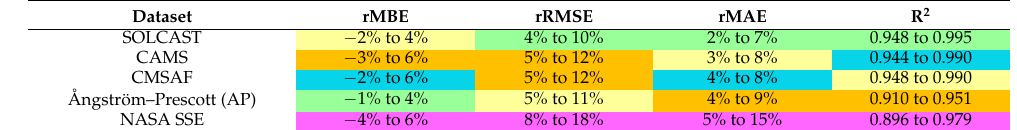
Table 7. Overall validation results under all-sky conditions. Green (1/5), yellow-low (2/5), blue (3/5), orange (4/5), and magenta (5/5) are used to describe the general performance ranking of the five datasets.